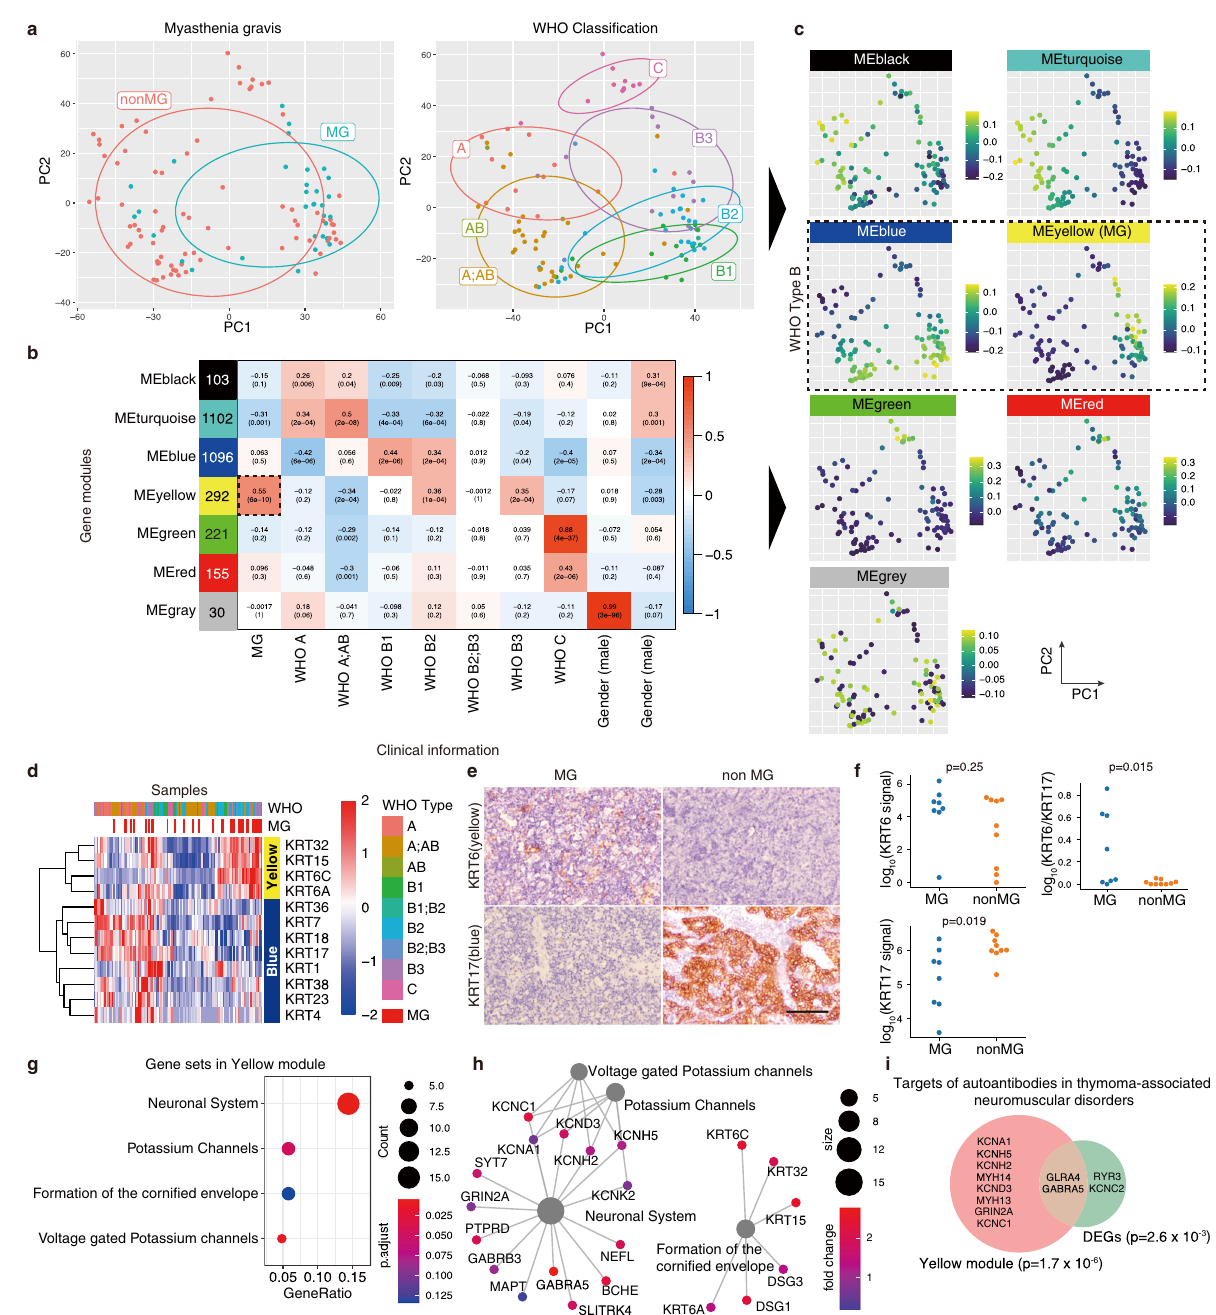
Fig. 1 Transcriptome pro fi ling of thymoma and MG-speci fi c expression of neuro-related genes. a PCA plots for transcription pro fi le of thymomas from 116 patients. The left panel shows the disease status, MG or non-MG, and the right panel shows WHO classi fi cation based on histology. b Gene modules de fi ned using WGCNA and the association with MG, WHO classi fi cation, gender, and age at diagnosis. Numbers in colored boxes on the left are the number of genes included in each module. The numbers in the heatmap show the correlation (upper) and the P -value (lower). c Eigengenes of each module for each patient on the PCA plot. d Heatmap of the gene expression of keratins in the yellow and blue modules. The color represents the Z-score of normalized expression by DESeq2. WHO classi fi cation and MG status were shown at the top of the heatmap. e Immunohistochemical (IHC) staining of KRT6 and KRT17 in MG and non-MG-thymoma. The scale bar: 100 µ m. f Protein levels of KRT6 and KR17, and KRT6 normalized by KRT17 in MG and non- MG-thymoma quanti fi ed using microscopic images (MG n = 8, nonMG n = 9, Details are provided in Supplementary Fig. 2, 3 and Methods. Source data are provided as a Source Data fi le.). The signals were analyzed using a two-sided Mann – Whitney U -test. g Signi fi cantly enriched REACTOME pathways in the yellow module. The node size represents the number of genes included in each pathway, and the color represents the adjusted P -value of the enrichment. The pathways were sorted by the ratio of genes included in the yellow module. h Genes in enriched REACTOME pathway in the yellow module. Genes with log 2 fold change > 1 in comparison of MG and non-MG were selected. i Venn diagram showing overlap of targets of autoantibodies associated with thymoma with genes in the yellow module and upregulated genes in MG. Data were analyzed using a two-sided Fisher ’ s exact